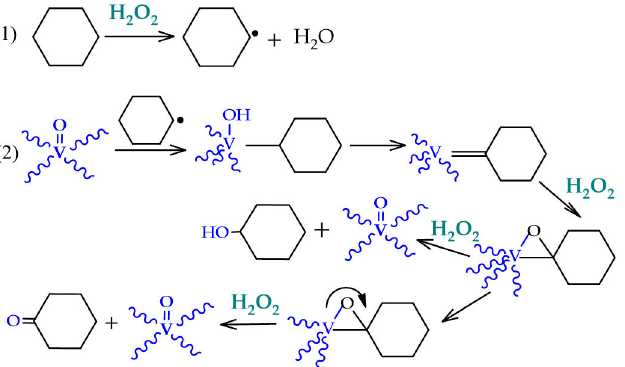
Figure 18. Proposed reaction mechanism for the oxidation of cyclohexane catalyzed by vanadium phosphate immobilized at KIT-6. Reproduction with permission from Reference [156]. Copyright (2017) Elsevier